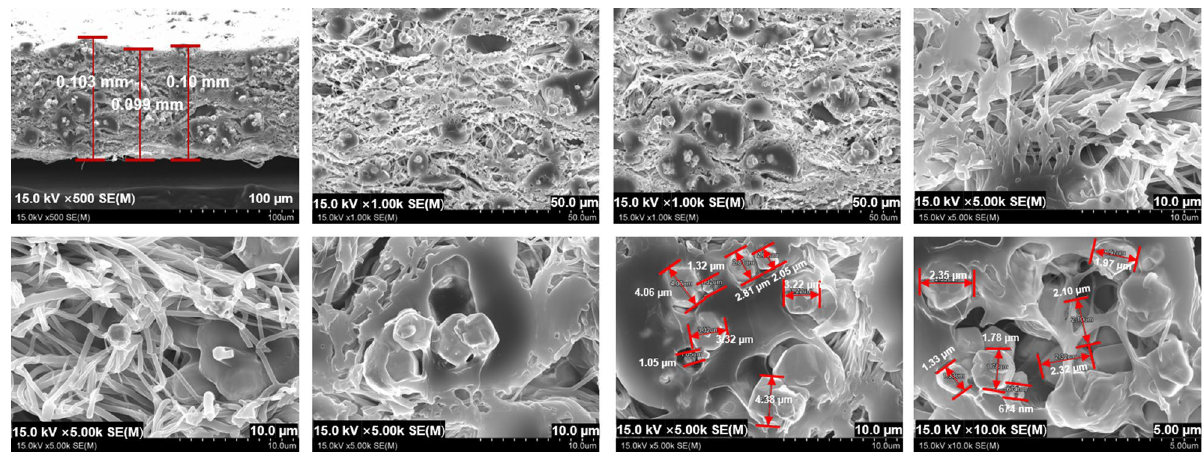
Figure 10. Cross-sectional electron micrographs of the shielding